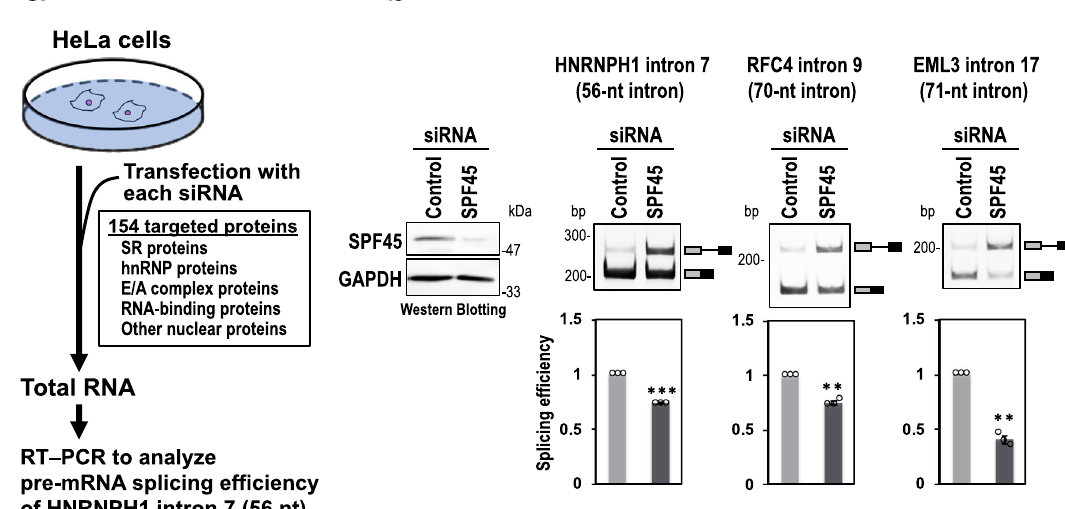
Fig. 1 SPF45 was identi fi ed by siRNA screening for HNRNPH1 pre-mRNA (with 56-nt intron) splicing. a The siRNA screening procedure to search for a speci fi c splicing factor for short introns. b The SPF45 protein depletion by siRNA-knockdown, using SPF45 #2 siRNA (see Supplementary Fig. S1b), in HeLa cells was checked by a Western blotting (left panel). After the siRNA transfection, endogenous splicing of the indicated three representative short introns were analyzed by RT-PCR (right 3 panels). Means ± SEM are given for three independent experiments and two-tailed Student t -test values were calculated (HNRNPH1 intron: p = 0.0001 for Control vs SPF45 siRNA; RFC4 intron: p = 0.0035 for Control vs SPF45 siRNA; EML3 intron: p = 0.0031 for Control vs SPF45 siRNA). ** P < 0.01, *** P < 0.001. Source data of the above panels are provided as a Source Data fi